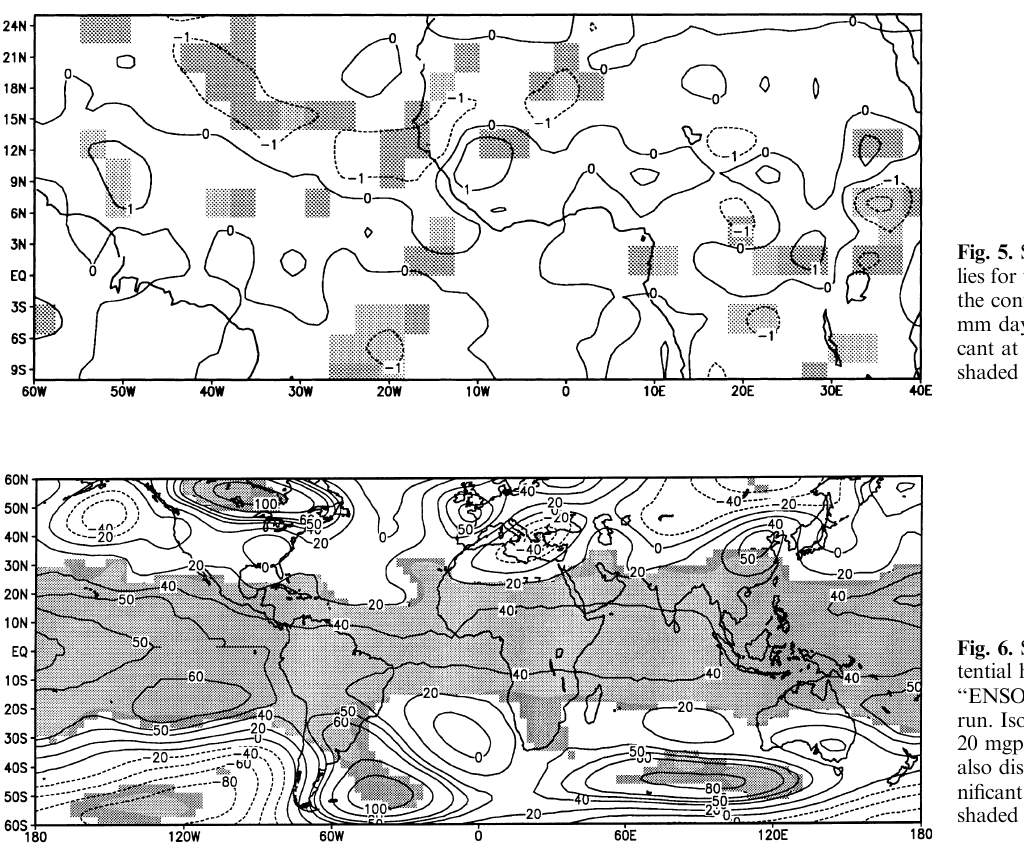
Fig. 6. Simulated 200-hPa geopo- tential height anomalies for the ‘‘ENSO’’ run relative to the control run. Isolines are in mgp every 20 mgp; the isolines 50 mgp are also displayed. Anomaly areas sig- nificant at the 5% (1%) level are shaded in dark ( light )